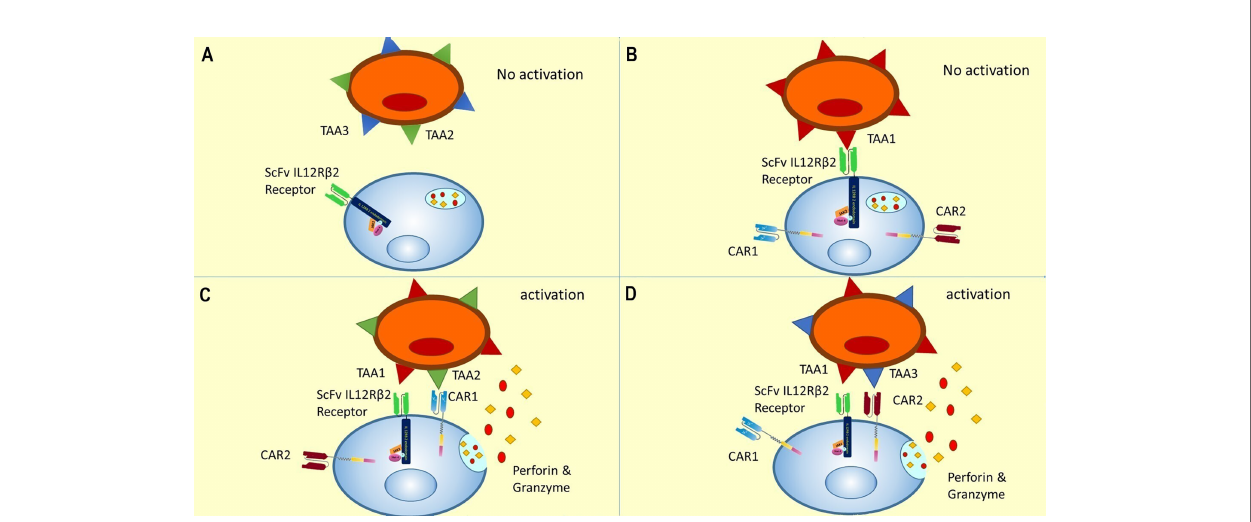
FIGURE 4 | A novel gate for CAR T cells activation encountering different TAA pro fi les (four out of eight are shown). (A) In the absence of TAA1, there is no initiation of JAK/ STAT pathway, no expression of CAR1 and CAR2, and accordingly no activation of CAR T cell. This condition could be representative of antigen pro fi les 5 to 8 in Table 1 . (B) Recognition of TAA1 in the absence of TAA2 or TAA3 leads to internal pathway activation and CAR receptor expression, but the CAR T cells could not be activated without recognizing TAA2 or TAA3. This condition is representative of antigen pro fi le 4 in Table 1 . (C) According to our proposed novel logic gate, the simultaneous presence of TAA1 and TAA2 leads to the activation of the JAK/STAT pathway due to recognition of TAA1 and induction of cytotoxic reactions due to recognition of TAA2. This condition was represented in the second antigen pro fi le in Table 1 . (D) Concurrent presence of TAA1 and TAA3 and recognition of them by the CAR T cell leads to JAK/ STAT activation and cytotoxic response. This condition is representative of the third antigen pro fi le in Table 1 . It can be easily concluded that the concurrent presence of all three antigens could lead to a cytotoxic response by activating CAR1 and CAR2, and this was represented in the fi rst antigen pro fi le in Table 1 .